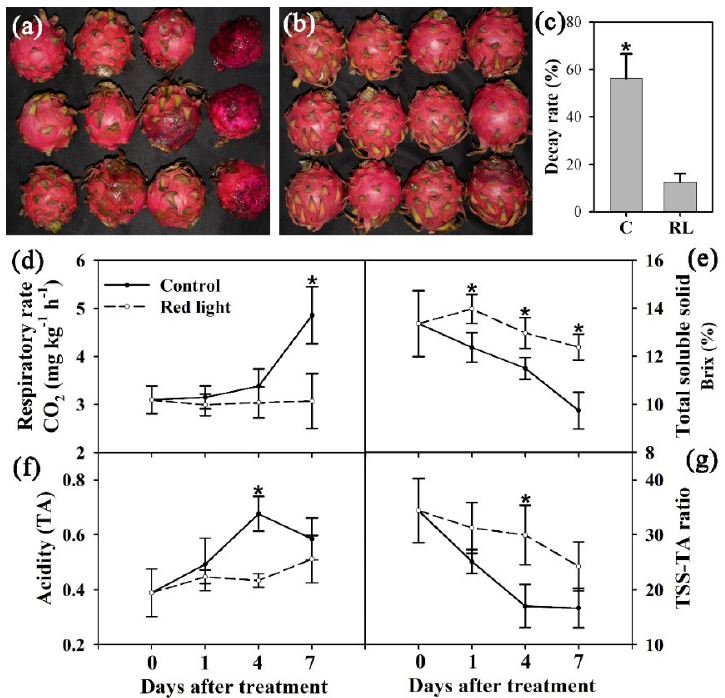
Figure 1. The effects of red light on pitaya fruit. The decay rate of pitaya fruit was measured on Day 10; ( a ): control. ( b ): red light. ( c ): decay rate. Control fruit: C; red light-treated fruit: RL. ( d ): respiratory rate. ( e ): total soluble solid. ( f ): acidity. ( g ): ratio of total soluble solid / acidity. The * on the error bar indicated statistically significant differences ( p < 0.05) between control and red light-treated samples.